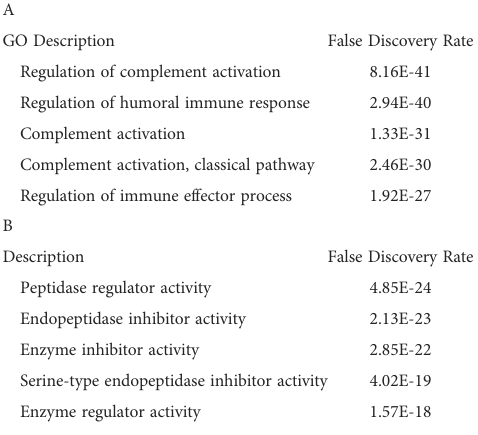
TABLE 3 Proteomic pathways in